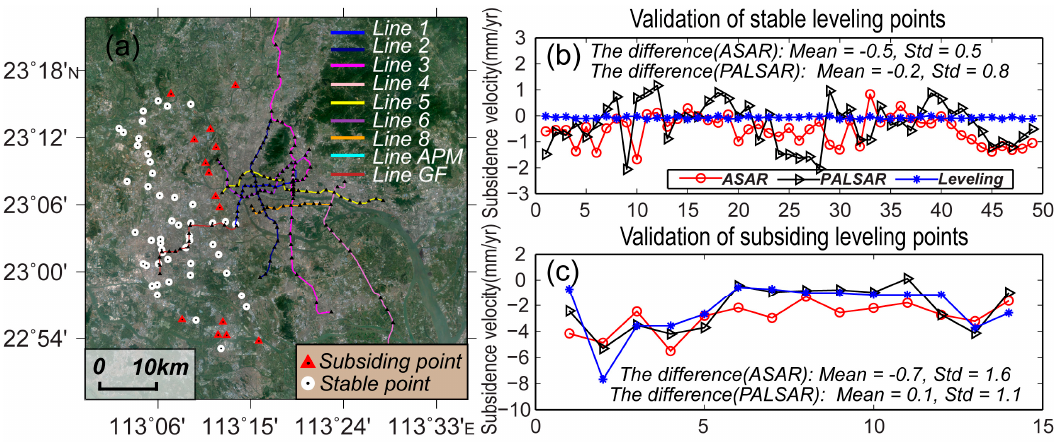
Figure 3. ( a ) Distribution of leveling points and location of Guangzhou subway network and ( b , c ) validations of IPTA results with leveling points.